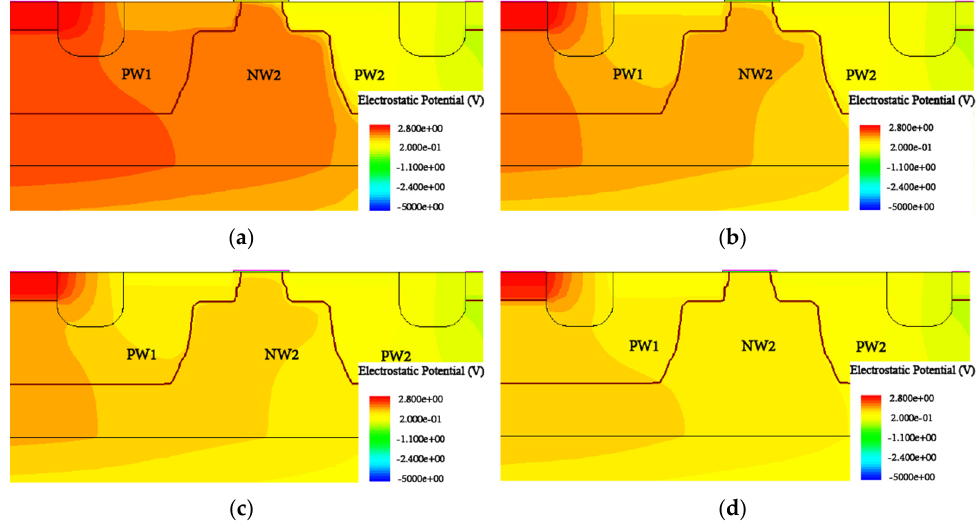
Figure 8. TCAD-simulated electric field distribution of PTBSCR (L = 0.5 μ m) when T1 is subject to a stress of I pulse = 75 μ A, T2 is grounded. The PTBSCR with ( a ) V G = 0 V, ( b ) V G = − 1 V, ( c ) V G = − 3 V, ( d ) V G = − 5 V.